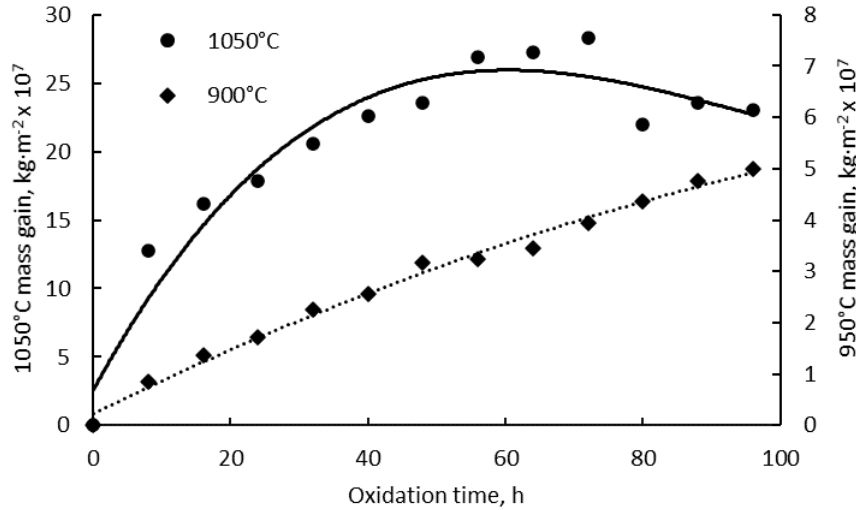
Figure 1. Kinetic curves of isothermal oxidation of IN 625 superalloy at 900 °C and 1050 °C.